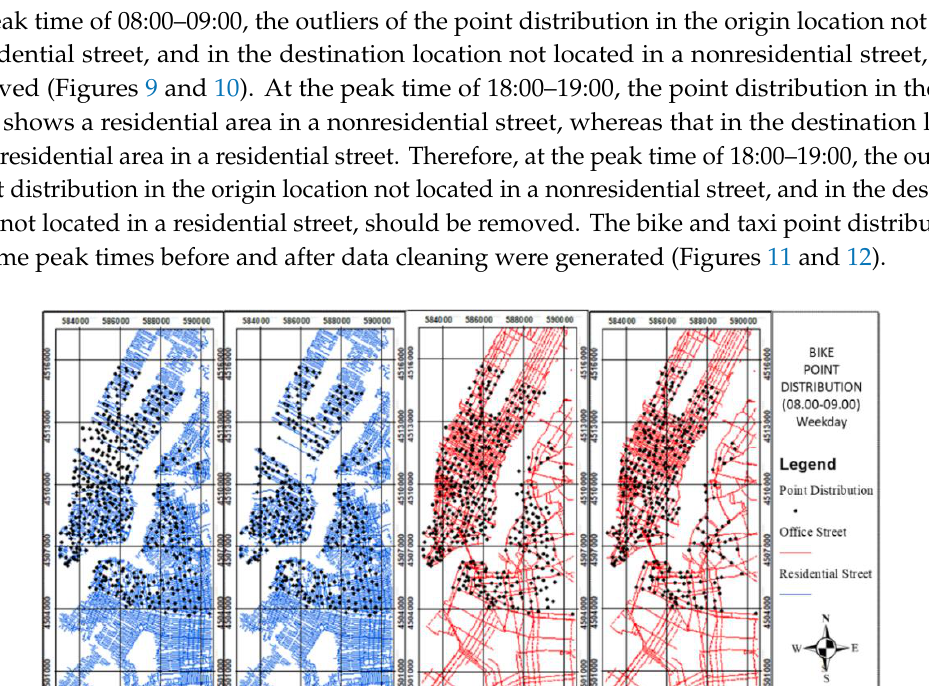
Figure 8. Bike and taxi density maps during weekend peak times: ( a ) bike origin density map at 17:00 –